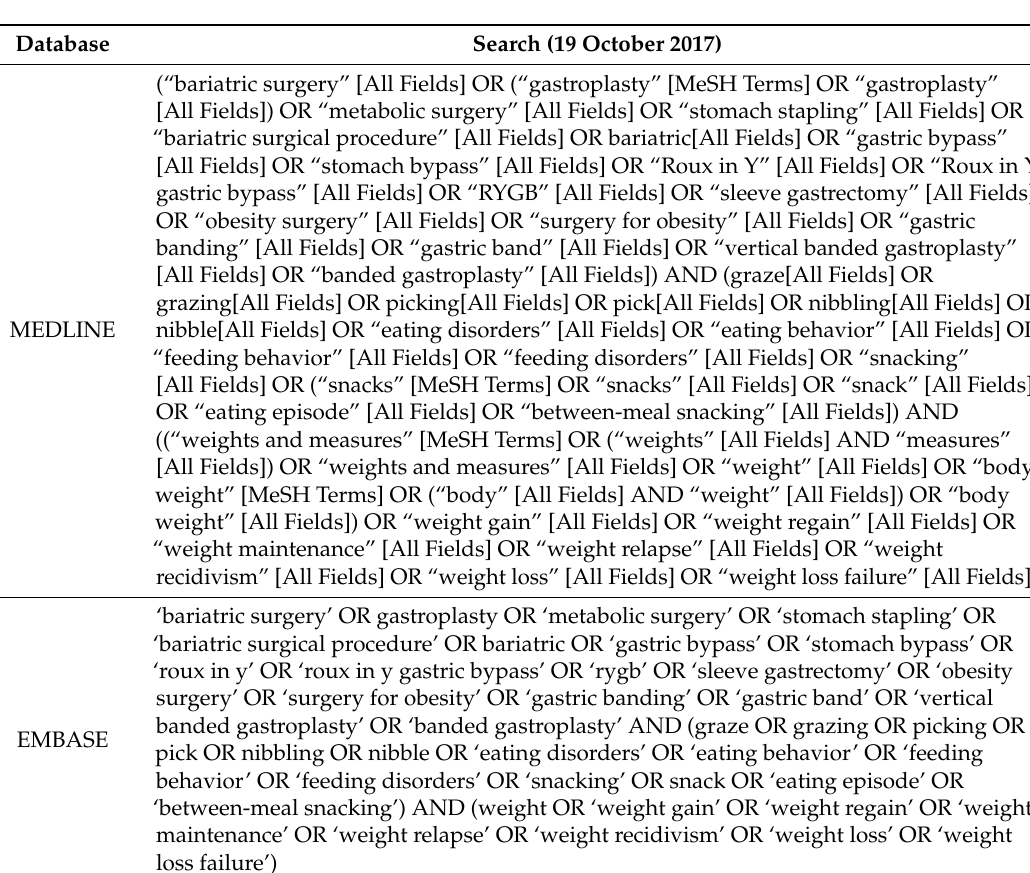
Table A1. Database search